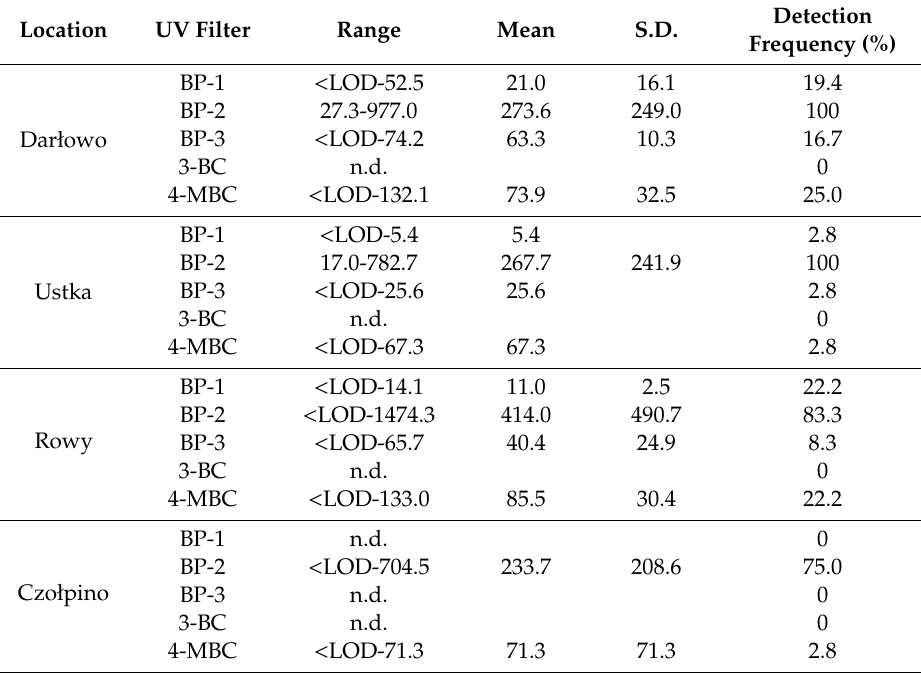
Table 3. Concentration range (ng · kg − 1 d.w.), mean concentrations (ng · kg − 1 d.w.), and detection frequencies (%) for UV filters in the core sediments of the Darłowo, Ustka, Rowy, and Czołpino beaches (n.d.—not detected).